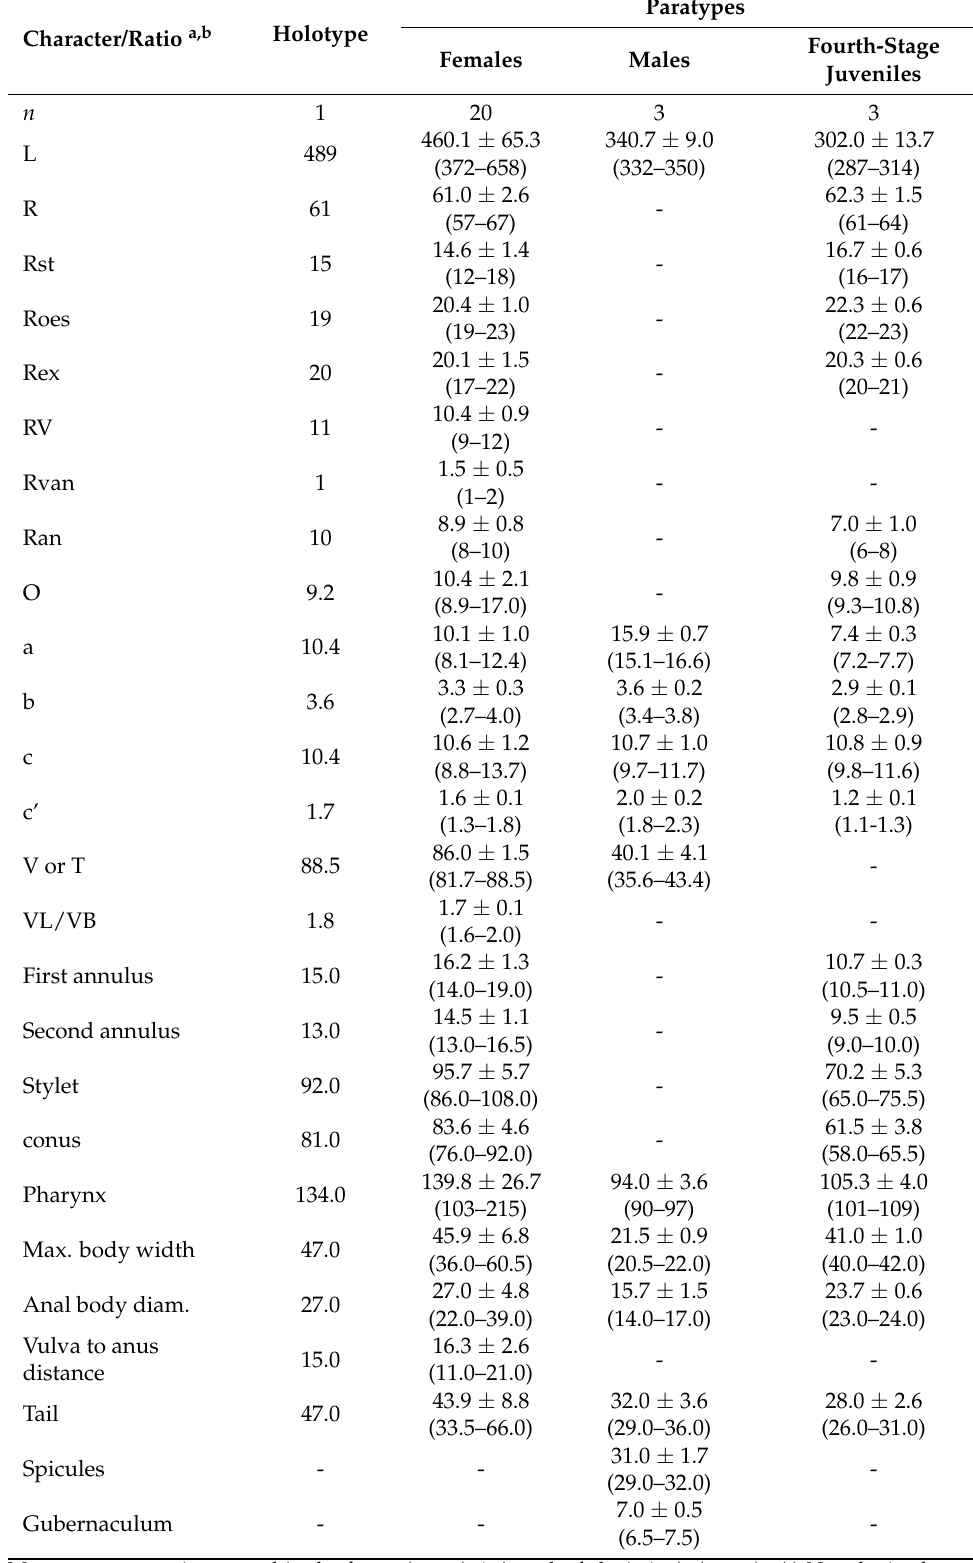
Table 5. Morphometrics of Criconema plesioannuliferum sp. nov. from common yew ( Taxus baccata